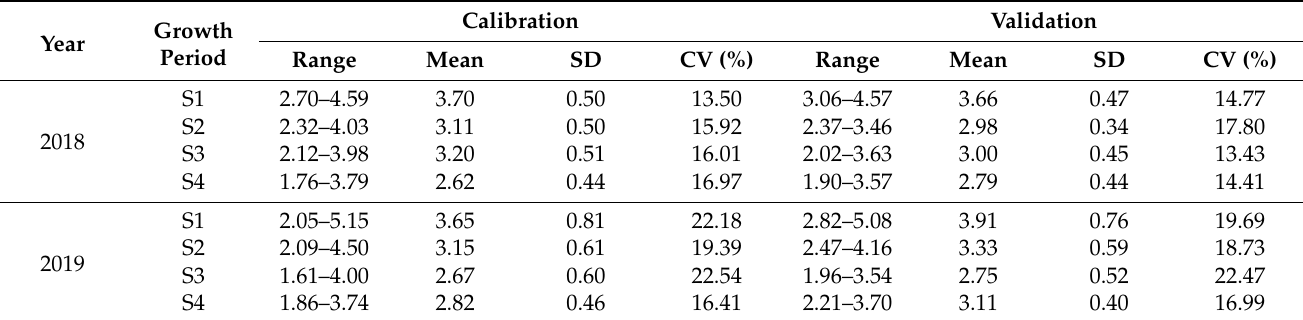
Table 2. Descriptive statistics of potato PNC for calibration and validation